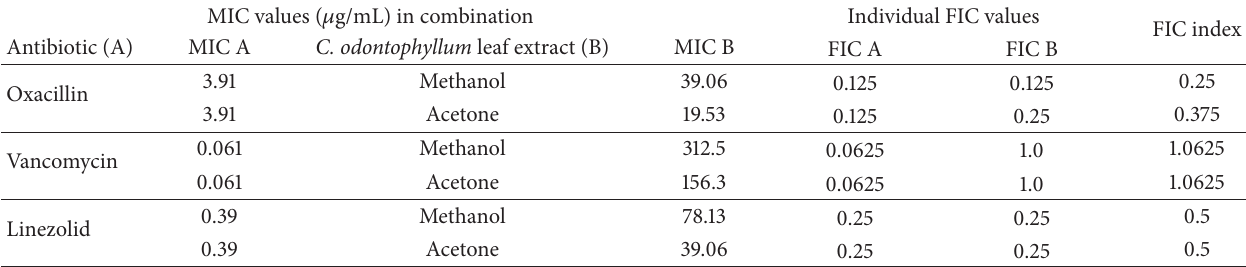
Table 2: FIC Indices for C. odontophyllum leaf extracts in combination with selected antimicrobial agents against MRSA ATCC 33591. MIC values ( 𝜇 g/mL) in combination